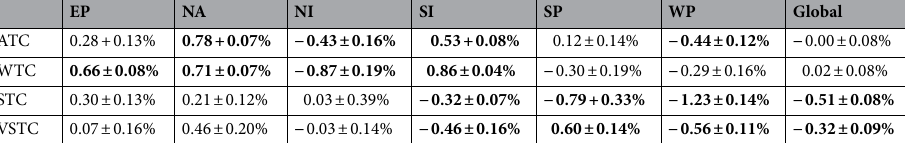
Table 2. The annual percent change in TC duration over the 1980–2019 period. Bolded numbers indicate statistically significant trends at α =